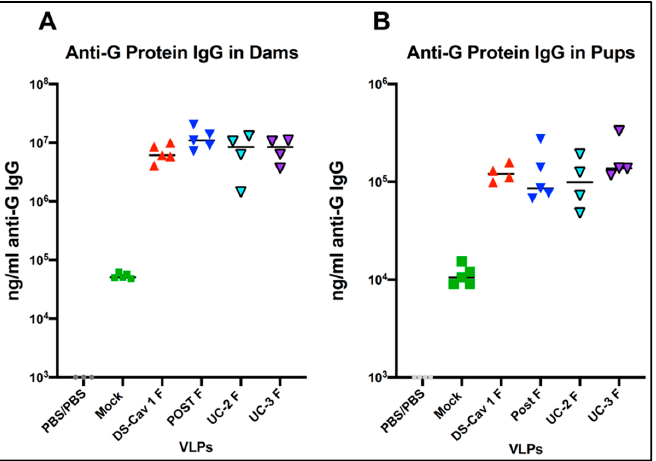
Figure 4. Induction of anti-G antibodies in VLP-immunized animals and their offspring. Five groups of RSV-primed, pregnant CR dams were immunized with 100 μ g of four different VLPs (DS-Cav1 F, Post F, UC-2 F, or UC-3 F VLPs or mock immunized) at 2 weeks of gestation. Panel A shows the ng/mL of anti-G IgG from individual dams immunized at 2 weeks of gestation. Panel B shows the ng/mL of pooled pup sera from each dam. There were no significant differences between groups of dams or between groups of pups.